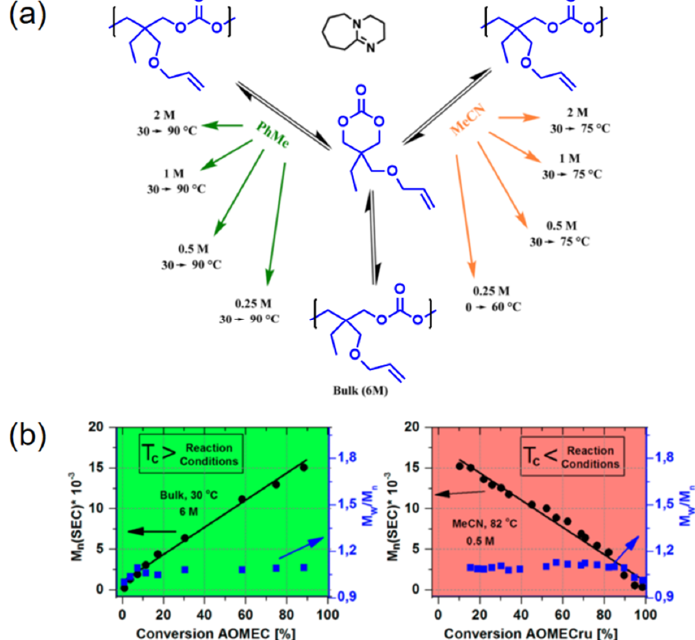
Figure 1. Reversible polymerization in ring-opening polymerization systems. ( a ) Reversible ROP of 2-allyloxylmethyl-2-ethyltrimethlene carbonate (AOMEC) at various reaction